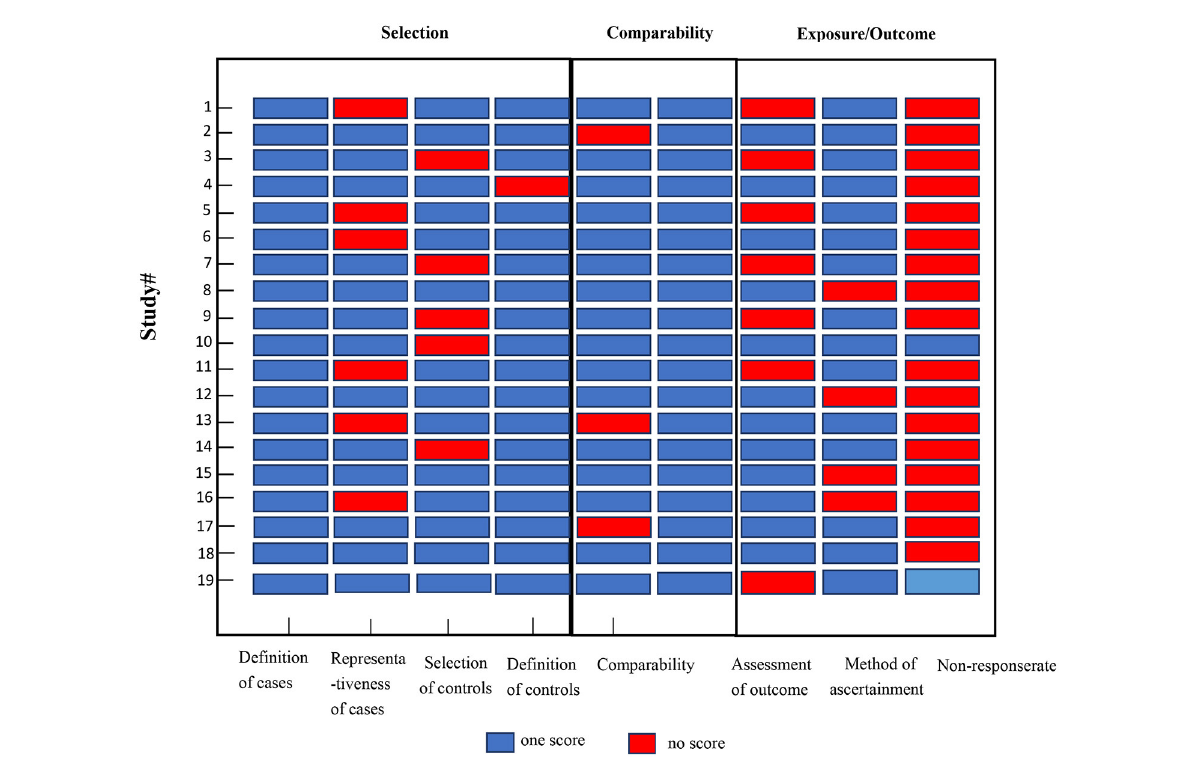
FIGURE2 Quality assessments of the included studies. Study # is the same as in Table